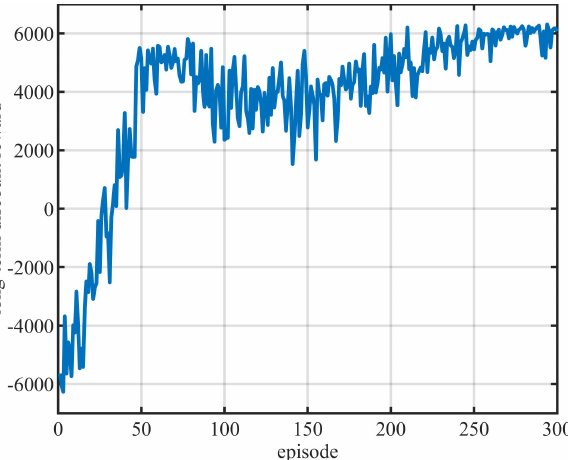
Figure 7. The curve of the long-term discount return with respect to the training episode in the wall-contacting